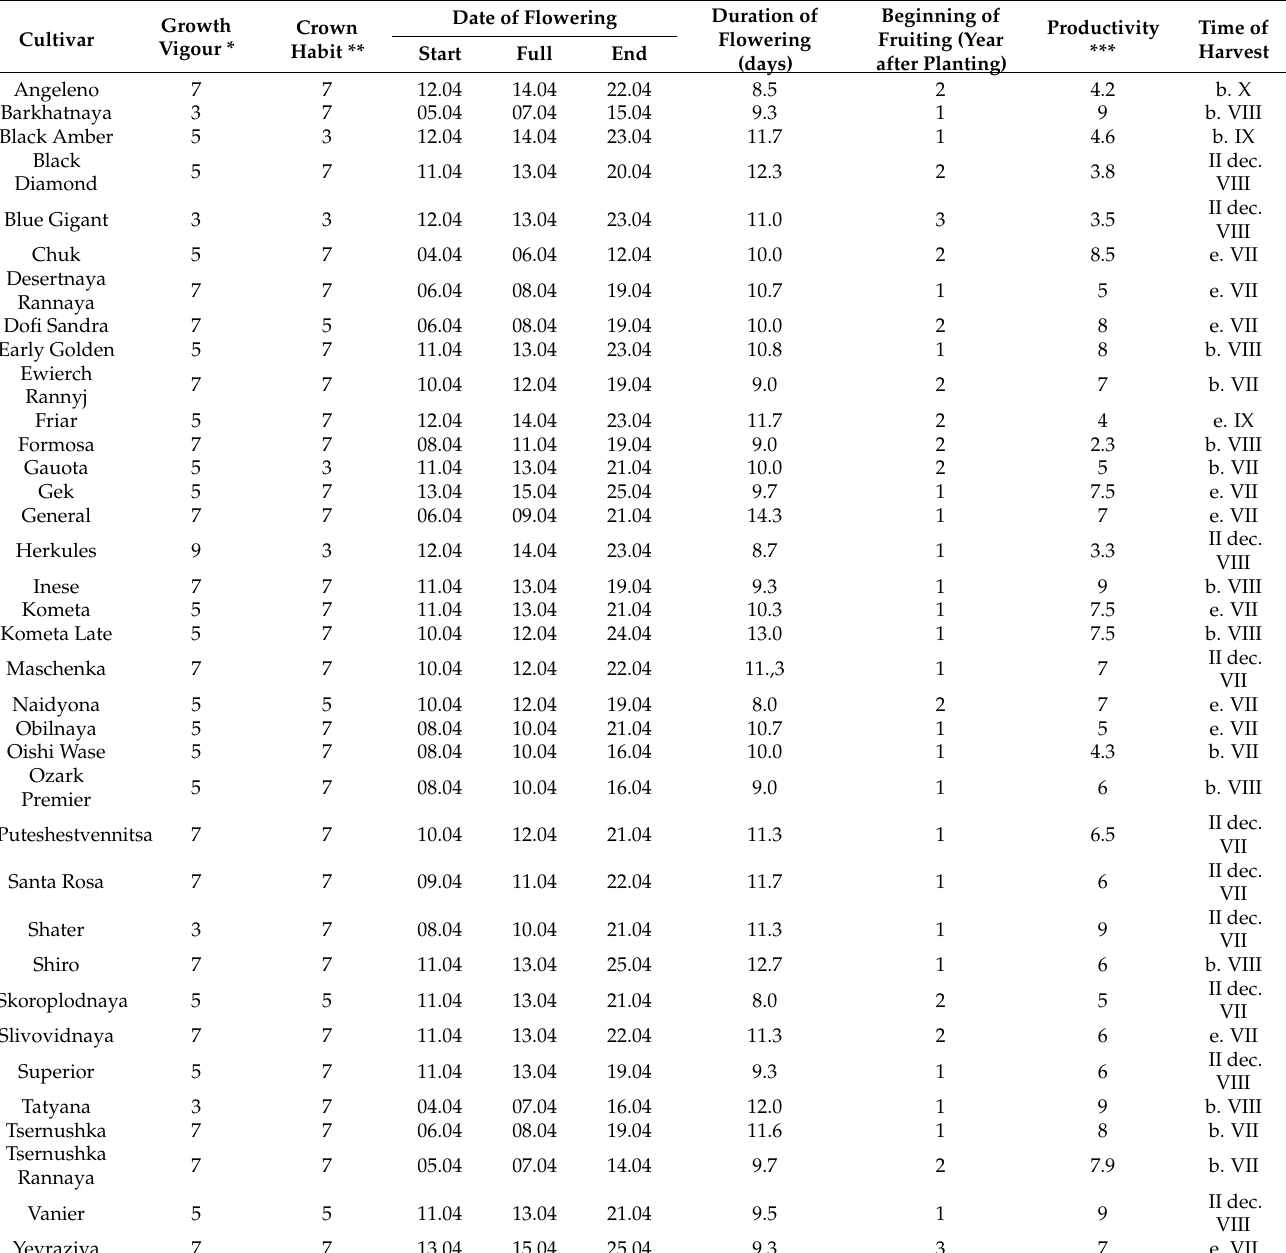
Table 2. Pomological characteristics and productivity of 36 P. salicina cultivars (average, 2015–2020).